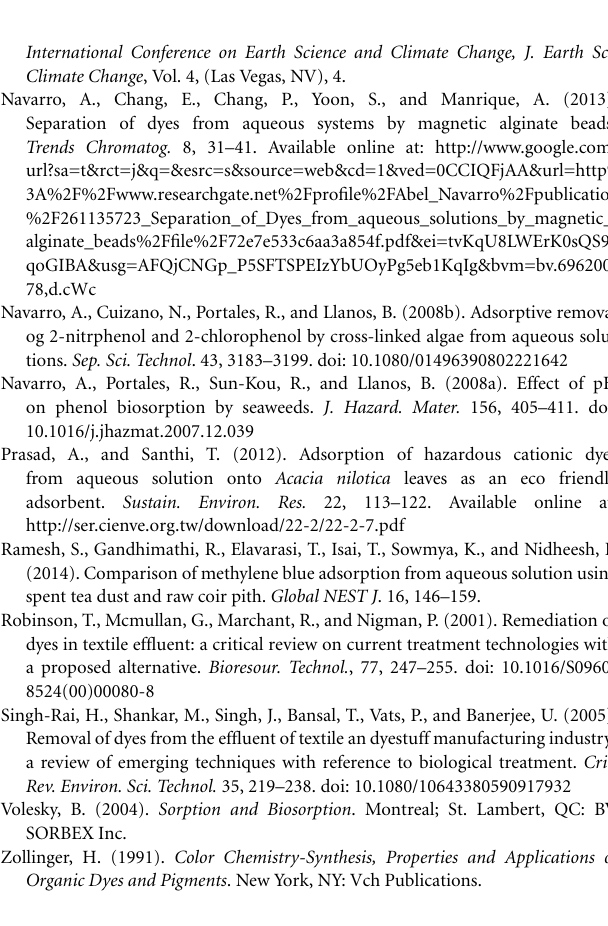
FIGURE 9 | Scanning electron microscopy analysis of the adsorbents: PM (left), CT (middle), and CM